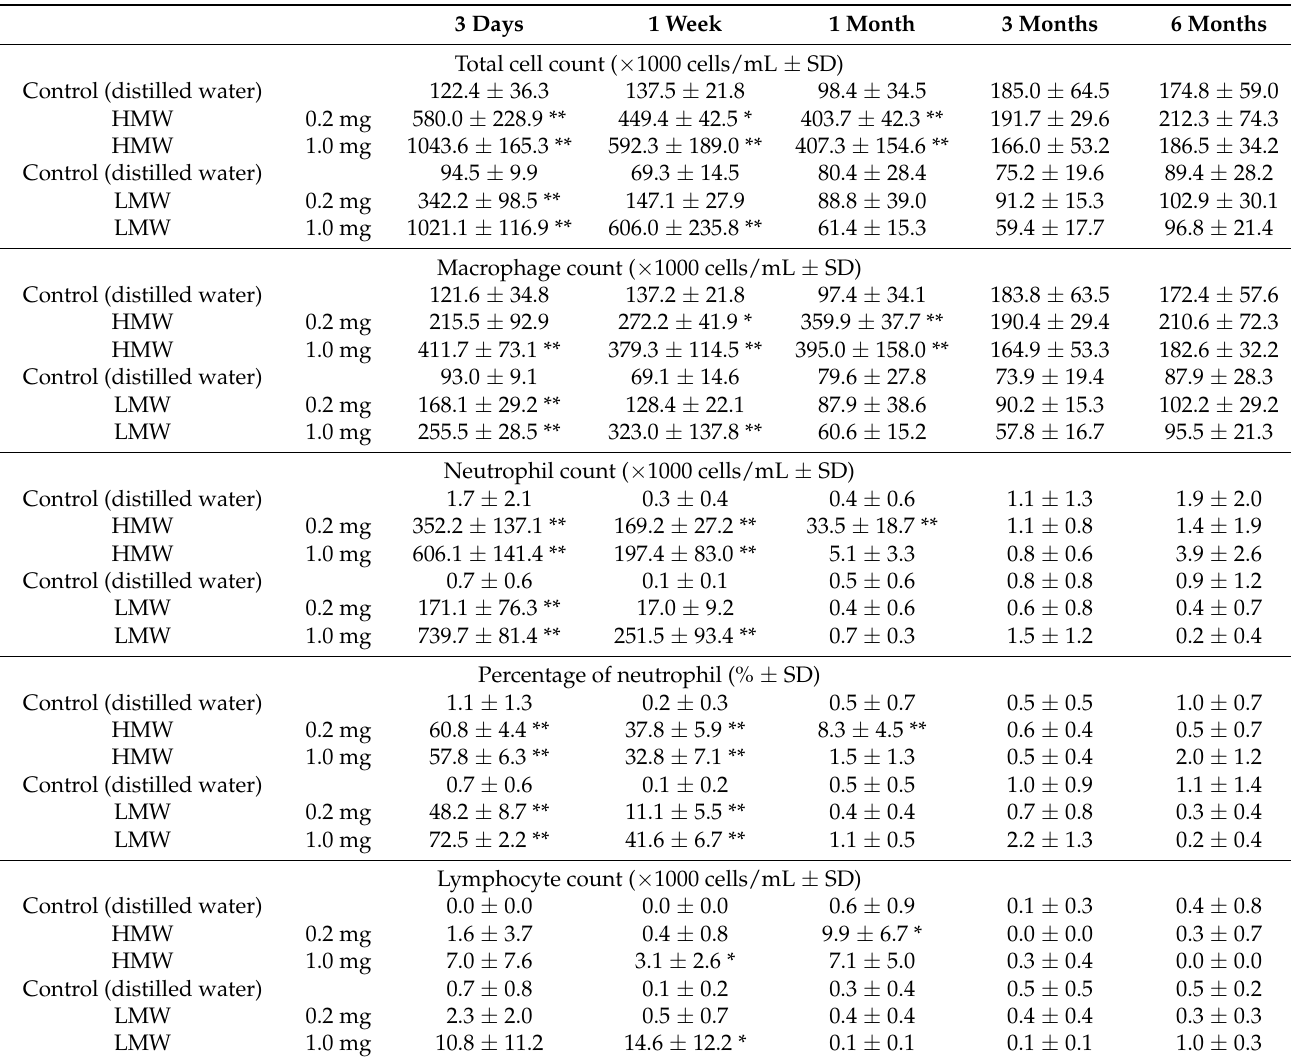
Table 3. Inflammatory cell counts in